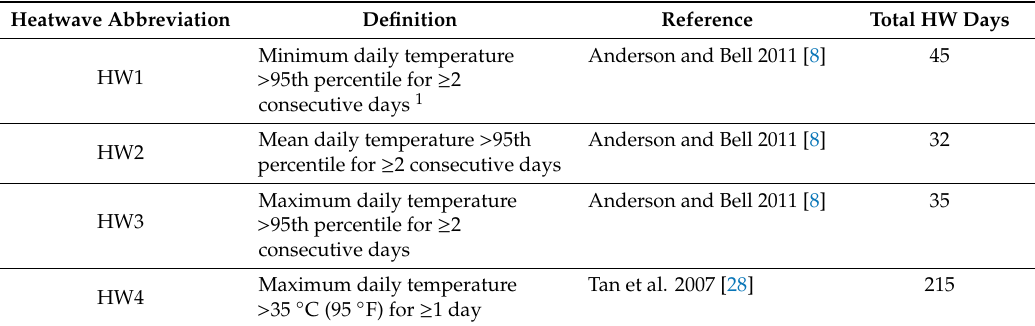
Table 1. Heatwave definitions used in this